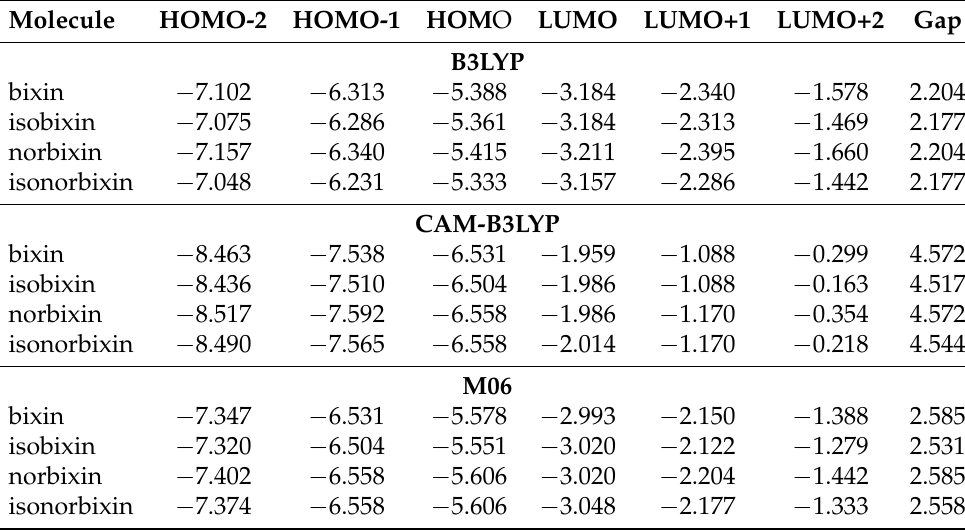
Table A9. Frontier MOs and gap energy values for the dyes in gas phase. These results were obtained by employing the 6-31+G(d,p) basis set. All values are in electron-Volt (eV).